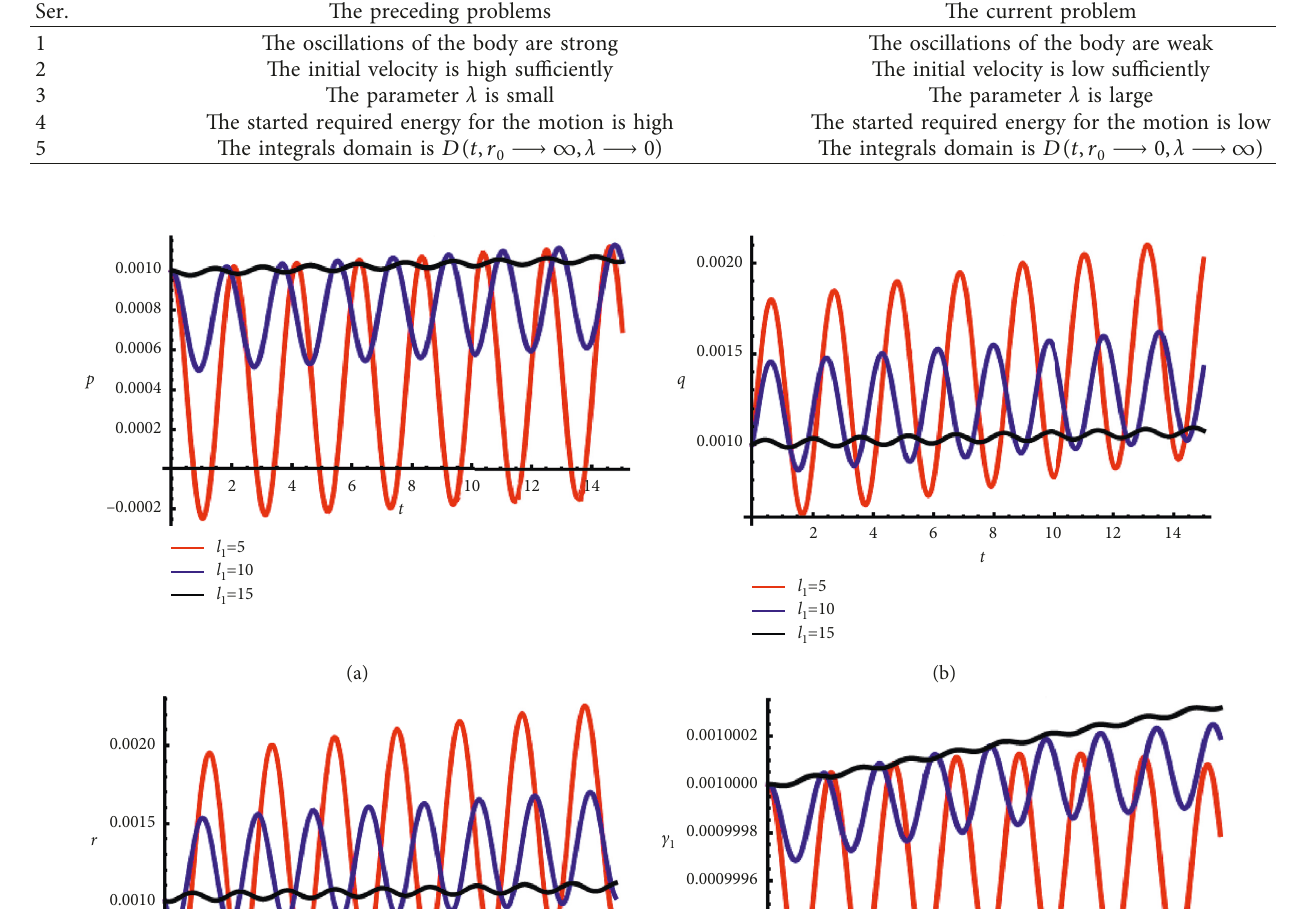
, c , and c with time when ℓ 1 2 3